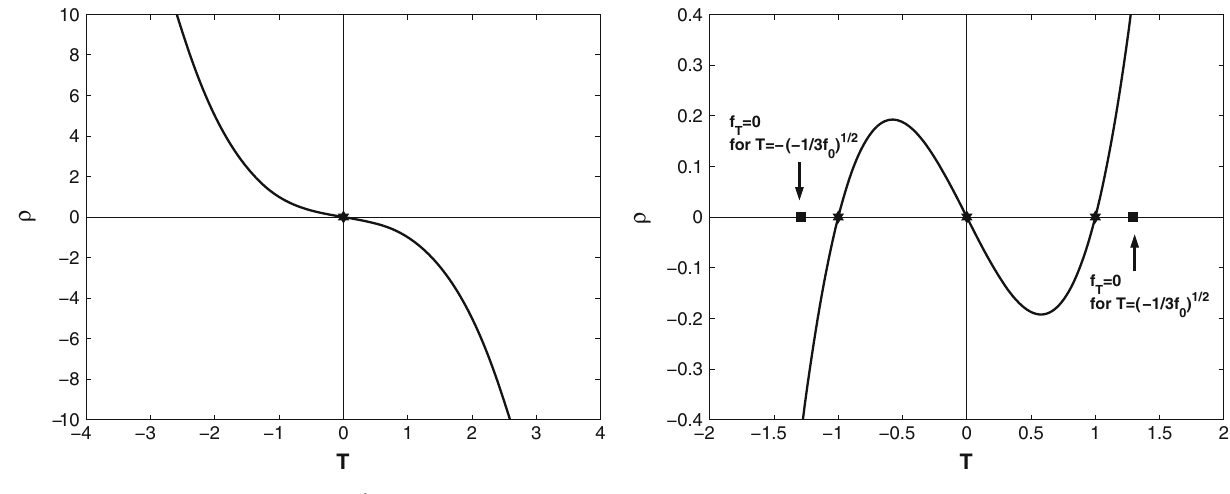
, which follows from the constraint equation (26) for N = 3. The parameter f 0 = 1 2 K